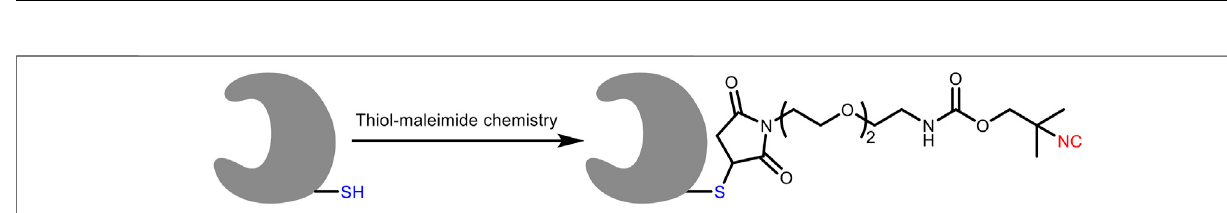
FIGURE 9 | Preparation of isocyanides by (A) the reaction of silver cyanide with alkyl iodide, (B) Hoffman carbylamine reaction with phase transfer catalysis, (C) ring-opening reaction of oxazole, (D) one-pot reaction using trimethylsilyl cyanide (TMSCN) and benzylic/tertiary alcohol, or (E) dehydration of formamide.